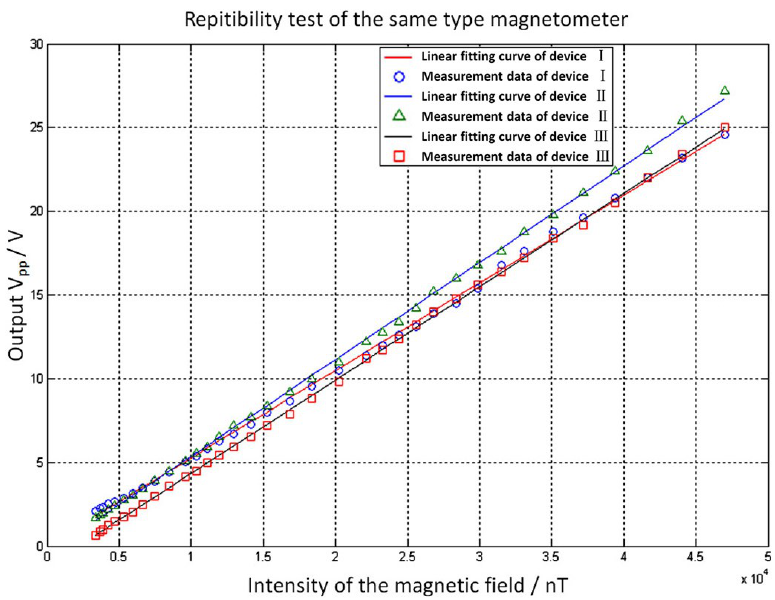
Figure 10. Linear fitting curves for measurement data of the micro magnetometer. Table 4. Results of the three measurements.